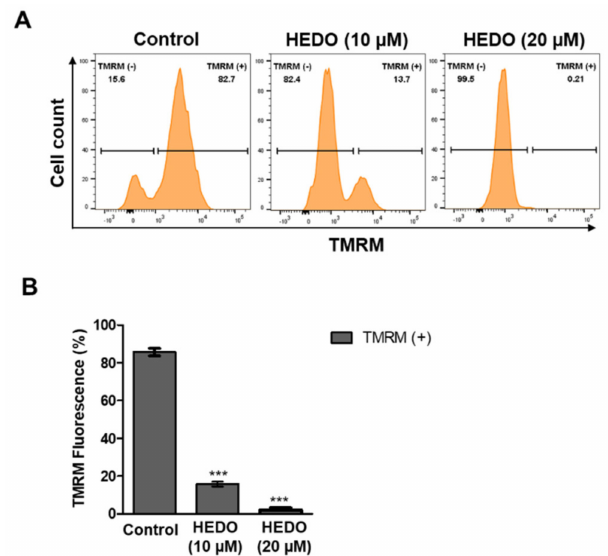
Figure3. DecreaseinmitochondrialmembranepotentialinOCI-LY3cellsduetoHEDO.( A )Mitochondrial membrane potential of OCI-LY3 cells loaded with tetramethylrhodamine methyl ester (TMRM) (100 nM), as detected by flow cytometry. ( B ) Quantification of the membrane potential in mitochondria, as measured by flow cytometry. Values indicate the means ± SEM. (n = 3, *** p ≤ 0.001).